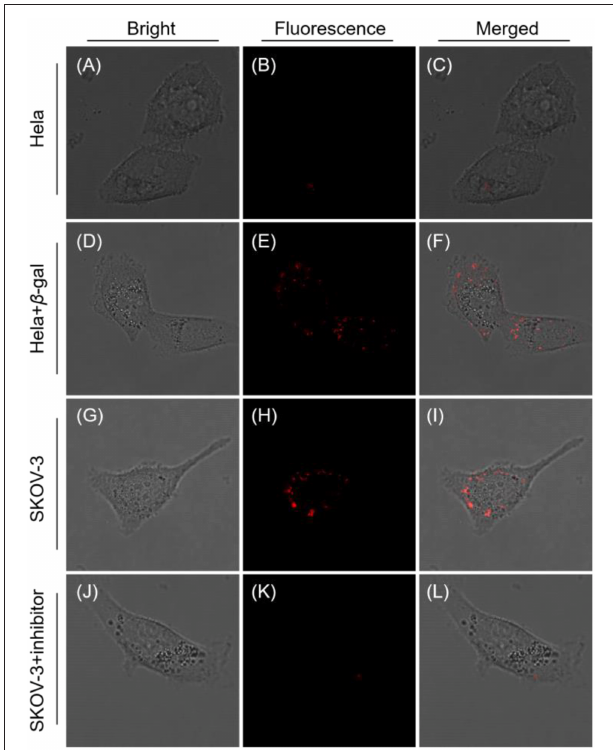
FIGURE 3 | Confocal laser scanning microscopy (CLSM) images of Hela and SKOV-3 cells incubated with QM-HBT- β gal (10 µ M) for 4 h: (A–C) Hela cells, (D–F) Hela cells pretreated with 1mM β -gal for 0.5h. (G–I) SKOV-3 cells, and (J–L) SKOV-3 cells pretreated with 1mM inhibitor for 0.5h. The window of fluorescence emission collection is 650–700nm, λ ex =